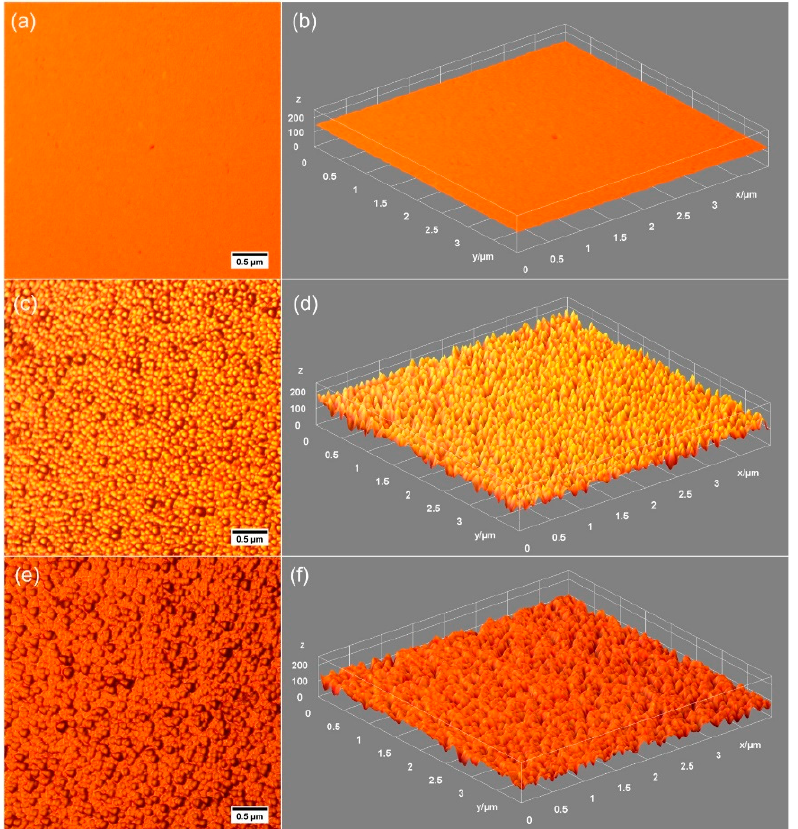
Figure 7. 2D Metallographic images (at 10× magnification) of CS–HAp coatings obtained at: p = 2 × 10 − 3 mbar ( a ); p = 5 × 10 − 3 mbar ( c ); p = 1.2 × 10 − 2 mbar ( e ). 3D representation of metallographic images obtained on CS–HAp coatings: p = 2 × 10 − 3 mbar ( b ); p = 5 × 10 − 3 mbar ( d ); p = 1.2 × 10 − 2 mbar ( f ).